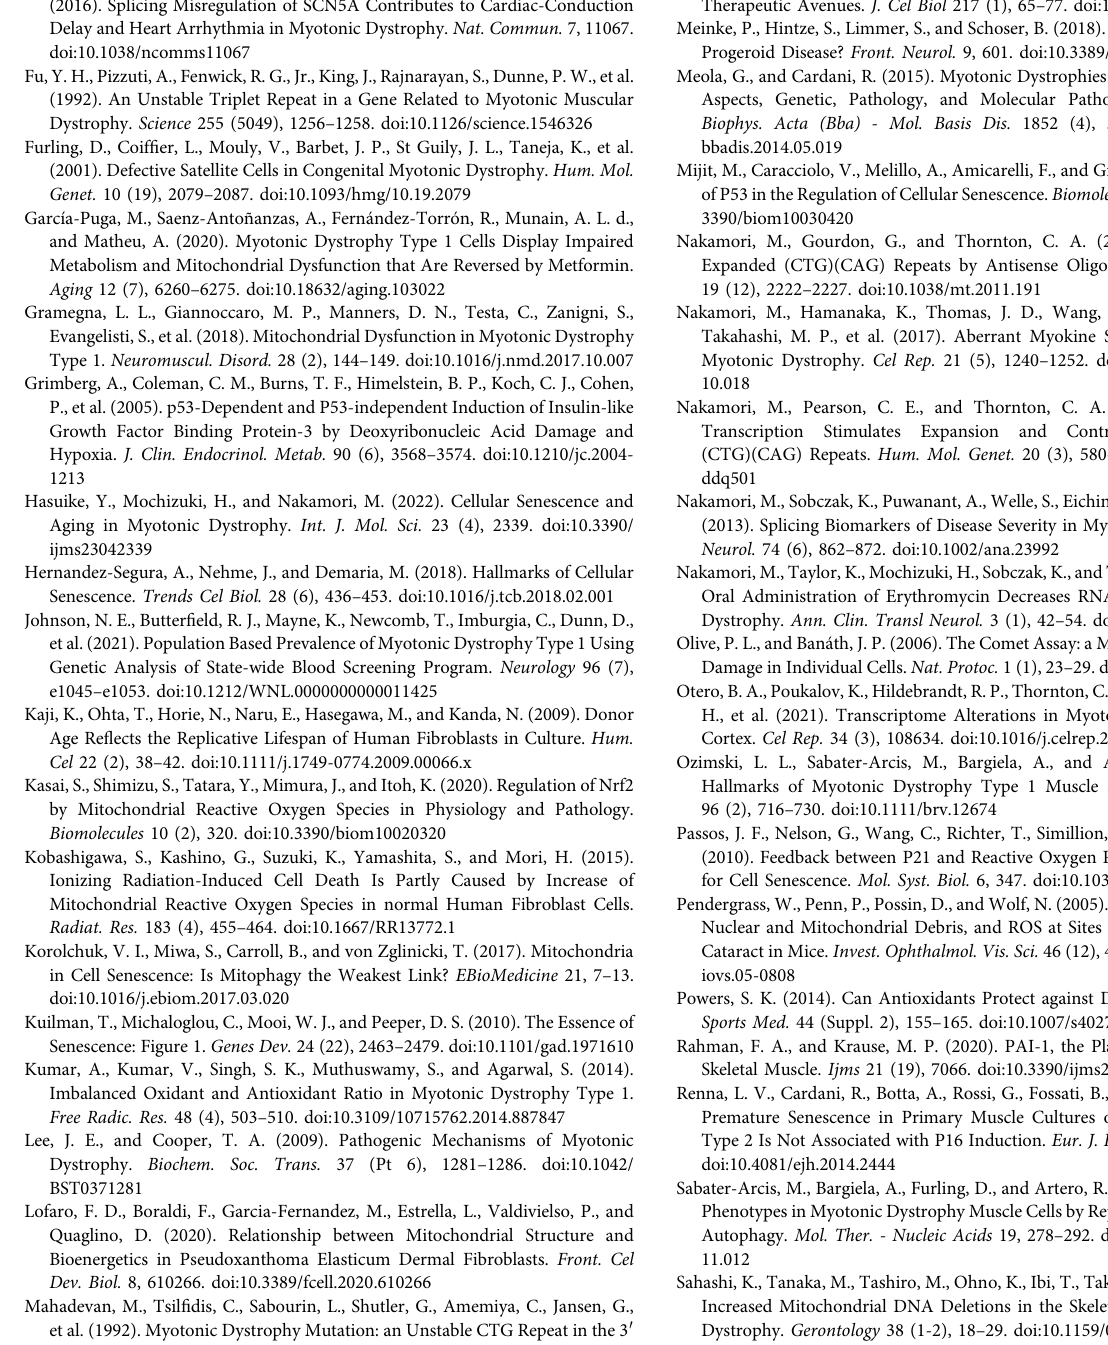
Senescence: Figure 1. Genes Dev. 24 (22), 2463 – 2479. doi:10.1101/gad.1971610 Kumar, A., Kumar, V., Singh, S. K., Muthuswamy, S., and Agarwal, S.